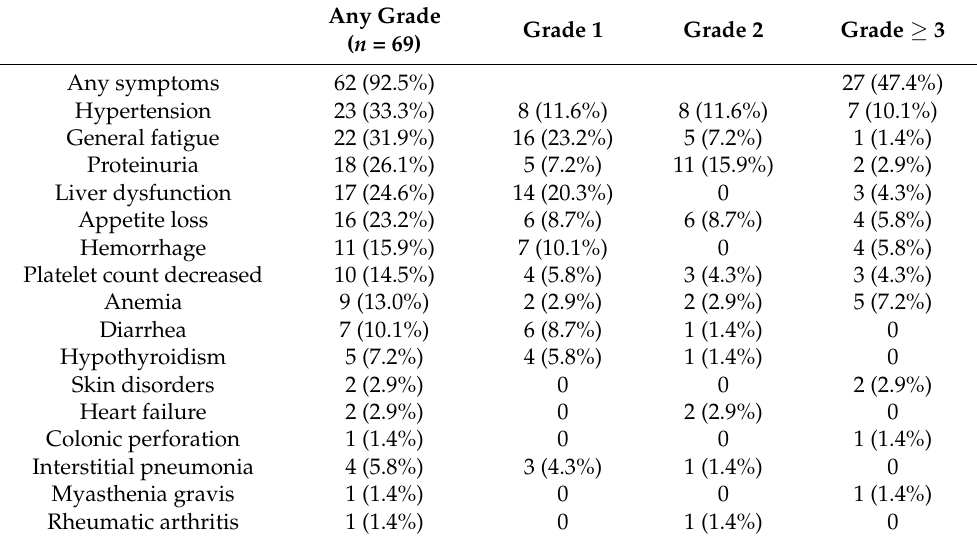
Table 3. Adverse events during atezolizumab plus bevacizumab treatment.